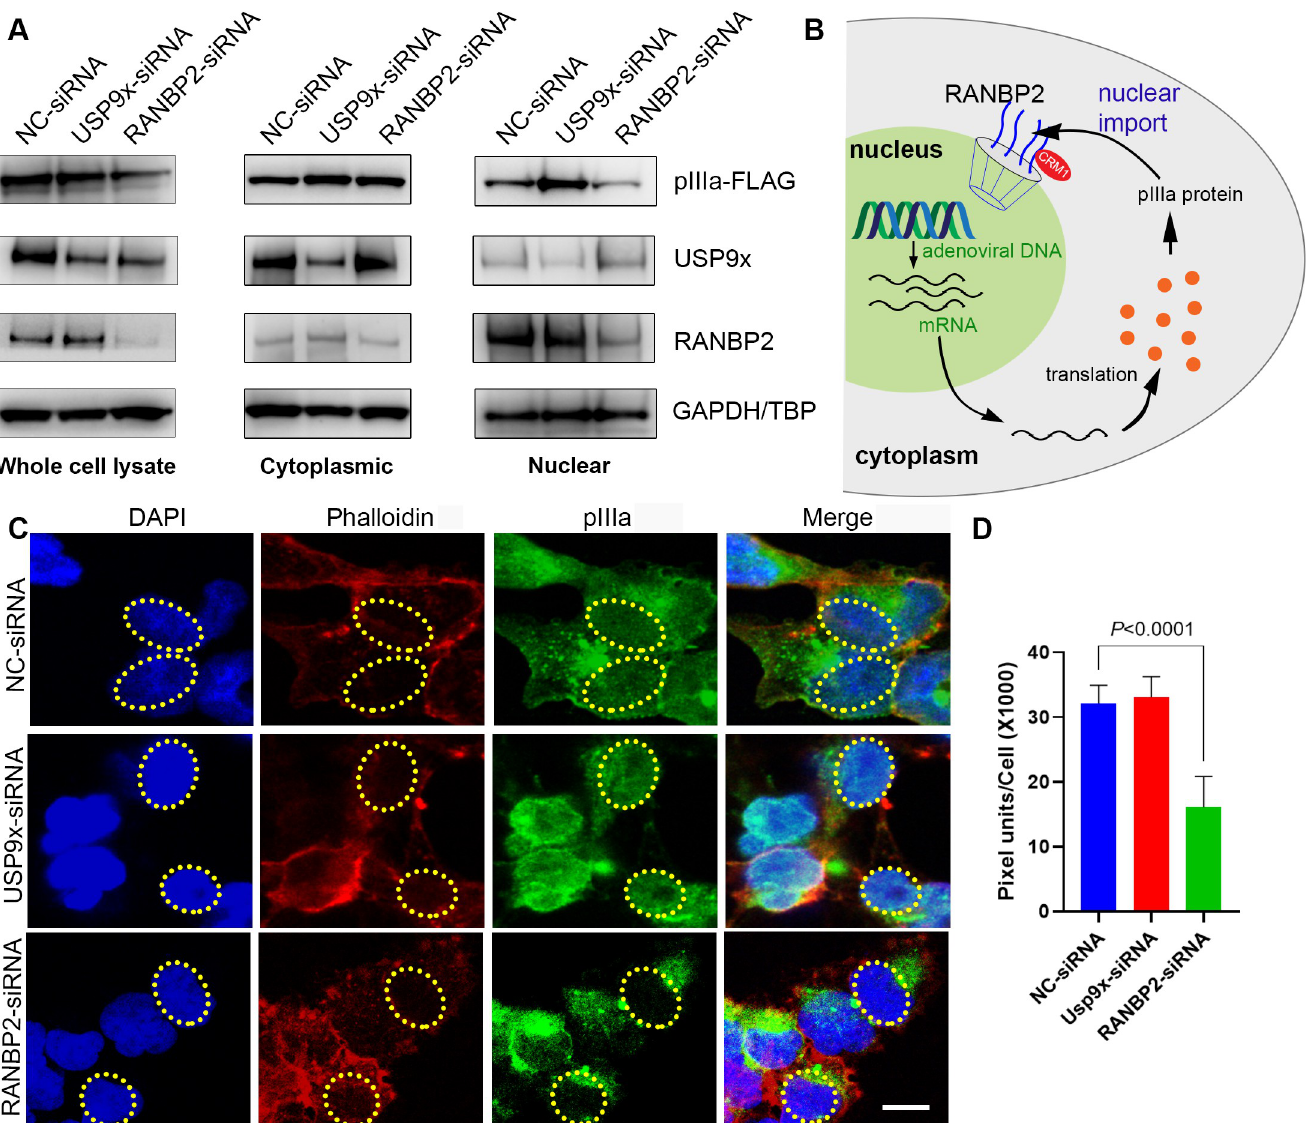
Fig 5. Human adenovirus pIIIa exploits RANBP2 nuclear import function. (A) Cytoplasmic and nuclear fractions of stable pIIIa expressing Flp-In 293 T-Rex cells treated with USP9x or RANBP2 siRNA for 48 hours, and then induced with tetracycline (20 ng/ μ L), and blotted for, pIIIa-Flag, RANBP2, USP9x and GAPDH protein expression (B) Schematic of the role of pIIIa-RANBP2 interaction in the adenovirus replication cycle. (C) Following Flp-In 293 T-Rex cells pretreated with USP9x or RANBP2-siRNA were tetracycline induced (20ng/mL) for 8 hrs for pIIIa expression. FLAG-pIIIa (green), phalloidin (red), and nuclei (blue) The dotted ellipse corresponds to the nucleus area. Scale bar: 10 μ m. (D) ImageJ analysis done on 30 cells per group and green fluorescence intensity was measured in the nucleus of each cell. The final data are presented as the mean ± SD of at least triplicate experiments. Statistical significance was performed with two-way ANOVA followed by Tukey multiple comparison test. Only comparisons where P < 0.05 are